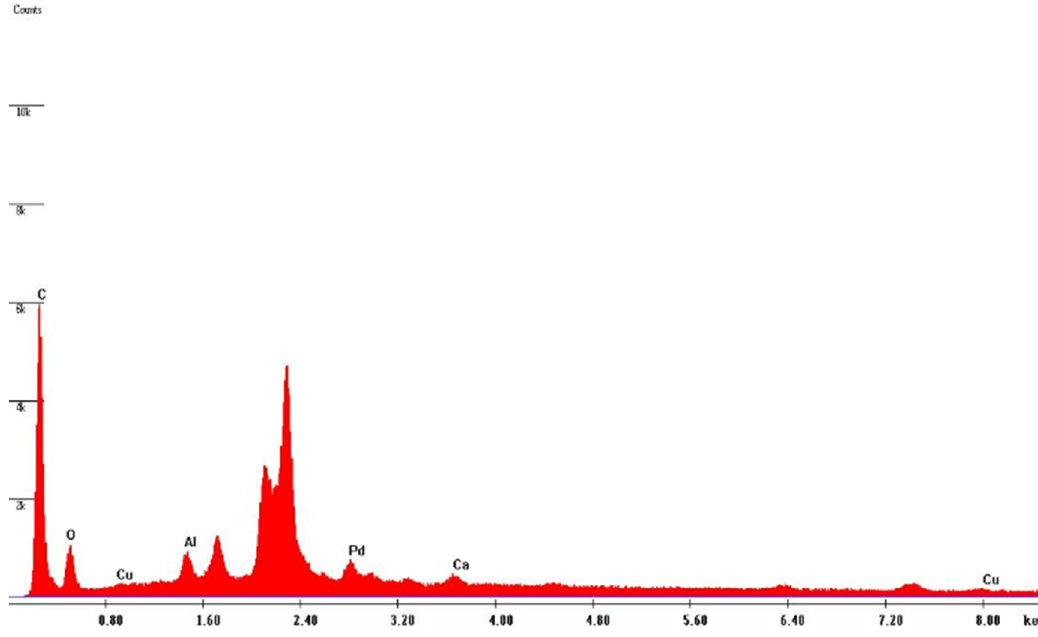
Figure 12: EDX pattern of 4Pd – 1Cu/TiO 2